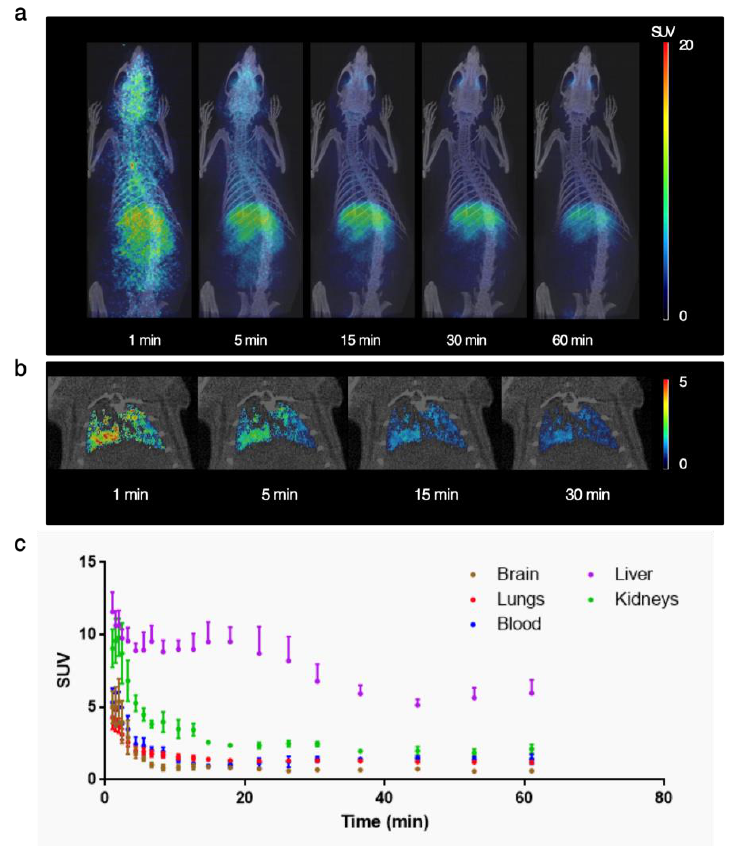
Figure 8. ( a ) Positron emission tomography (PET) images (maximum intensity projections, coronal views) obtained at different time points after intratracheal administration of 1- 11 C-ethanol. Images have been coregistered with 3D-rendered computed tomography (CT) images for anatomical localization of the radioactive signal; ( b ) PET images (coronal projections) corresponding to the segmented lungs at different times points after administration; images have been coregistered with representative CT slices; ( c ) time activity curves obtained after quantification of volumes of interest drawn in different organs. Values are expressed as standard uptake values (SUV), mean ± standard error mean, n = 3.